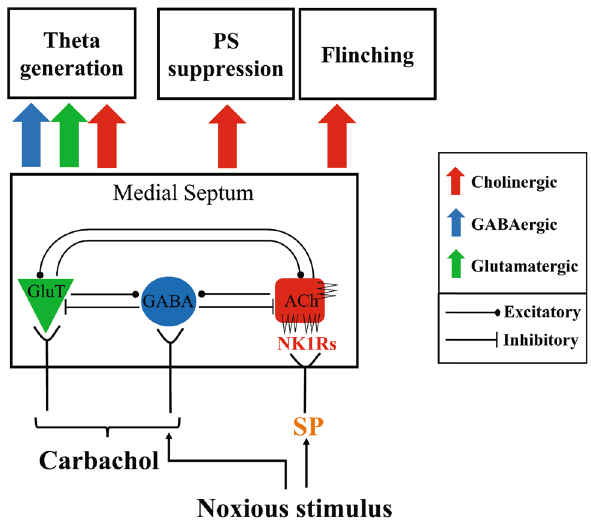
Figure 8. A model of NK1R-mediated nociception in the formalin test. The diagram depicts septal cholinergic neurons (Ach) which are interlinked with the local non-cholinergic neurons, namely GABAergic (GABA) and glutamatergic (GluT) neurons 66,67 . Pertinent here is that the neurokinin NK1Rs are localized to the cholinergic neurons in the region. The present study suggests the septal NK1Rs modulate formalin nociception. For instance, SP, an agonist at NK1Rs, and injection of formalin equally evoke a suppression of CA1 PS that